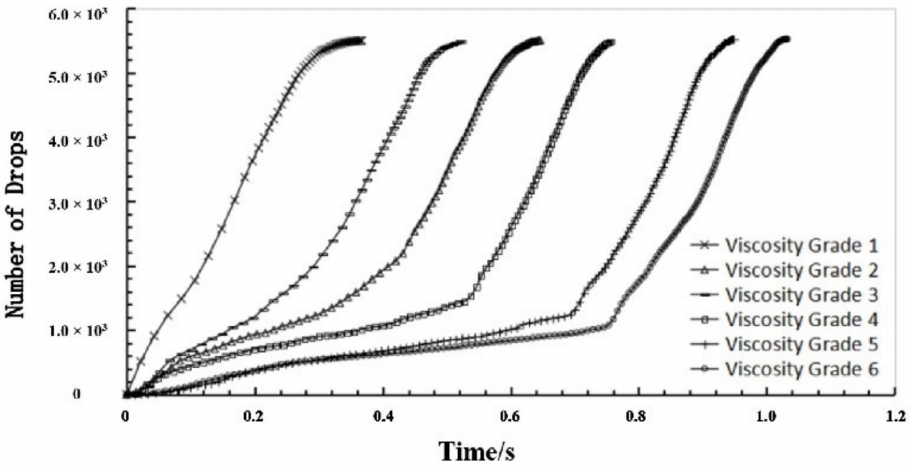
Figure 5. The curves between number of powder spheres squeezed from sieve and time under different viscosity grade.